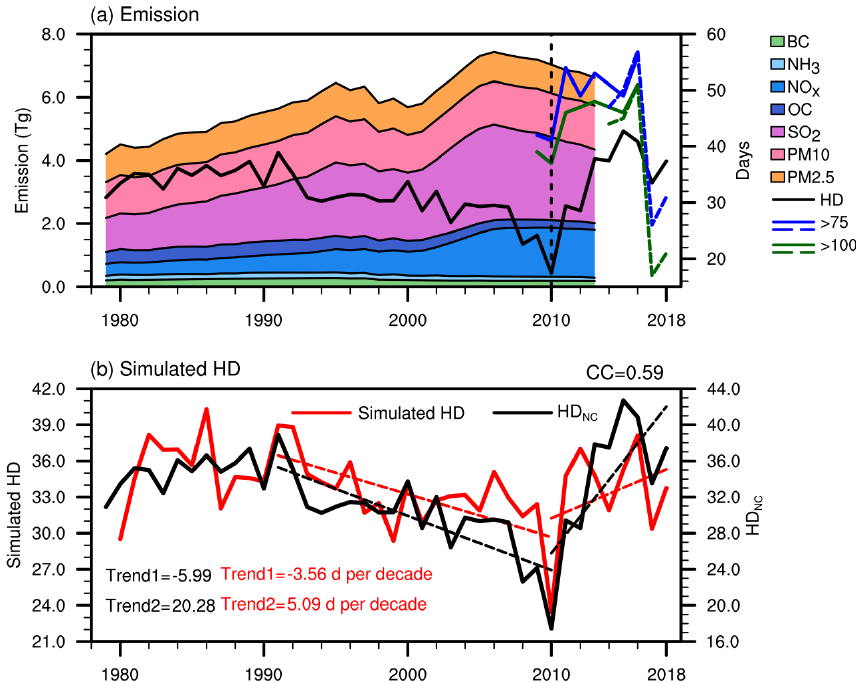
Figure 1. (a) Variations in the December and January emissions (unit: Tg) of black carbon (BC), ammonia (NH 3 ), nitrogen oxide (NO x ), organic carbon (OC), sulfur dioxide (SO 2 ), PM 10 and PM 2 . 5 over North China from 1979 to 2013 and the variation in HD NC from 1979 to 2018 (black solid line). The blue and green solid (dashed) lines indicate the number of days when the hourly PM 2 . 5 concentrations exceeded 75 and 100µgm − 3 , respectively, from 2009 to 2016 (2014 to 2018) using Beijing (North China) observed data from the US embassy (China National Environmental Monitoring Centre). (b) Temporal evolution of HD NC (in black) and simulated haze days (unit: days; red) in NC. The dashed lines denote linear regressions for 1991–2010 (P1) and 2010–2018 (P2). Trend 1 and Trend 2 represent the linear trends of the observed (black) and simulated (red) haze days in P1 and P2,